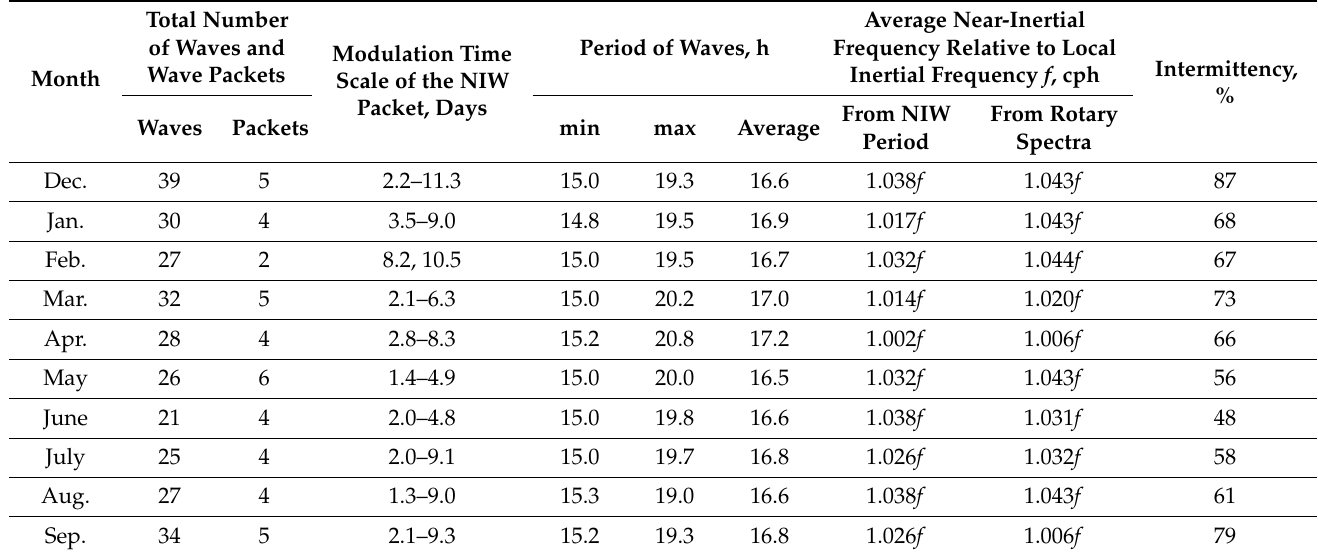
Table 1. Near-inertial waves at 100 m depth for individual months,